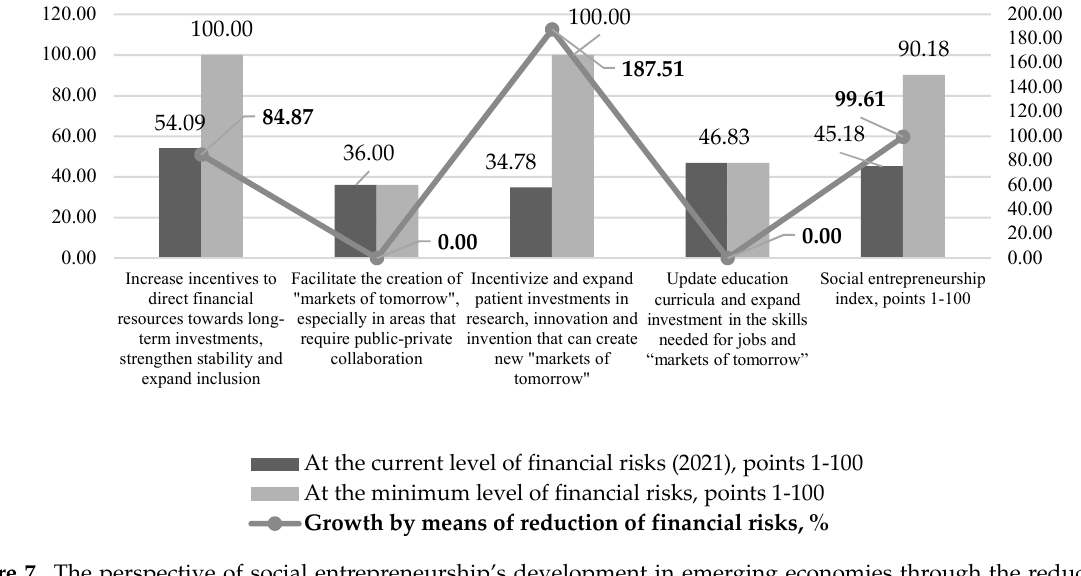
Figure 7. The perspective of social entrepreneurship’s development in emerging economies through the reduction of financial risk. Source: Authors.